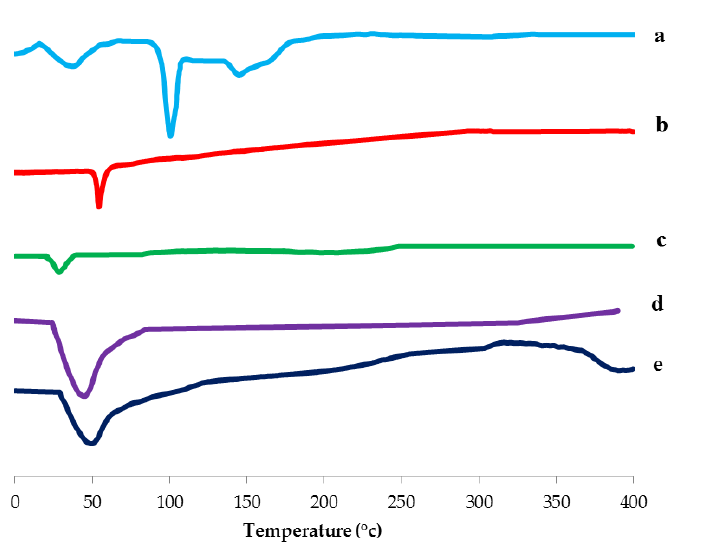
Figure 8. DSC thermogram of ( a ) SV, ( b ) Span 60, ( c ) Cremophor RH, ( d ) Plain spanlastics and ( e ) optimized SV-loaded SNVs(F8). Abbreviations: SV, Sodium valproate.